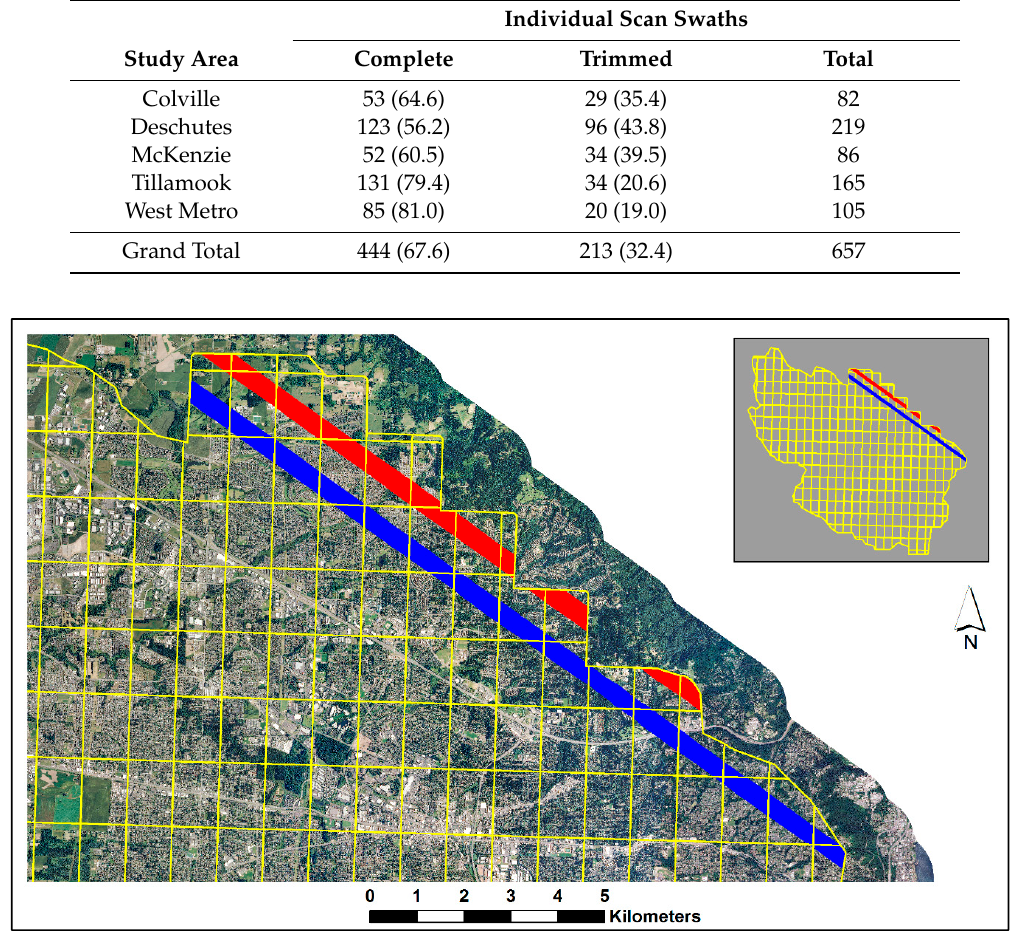
Figure 5. Example of complete (blue) and trimmed (red) scan swaths in the West Metro area superimposed on panchromatic NAIP imagery. Polygons with yellow outline denote data delivery tiles.